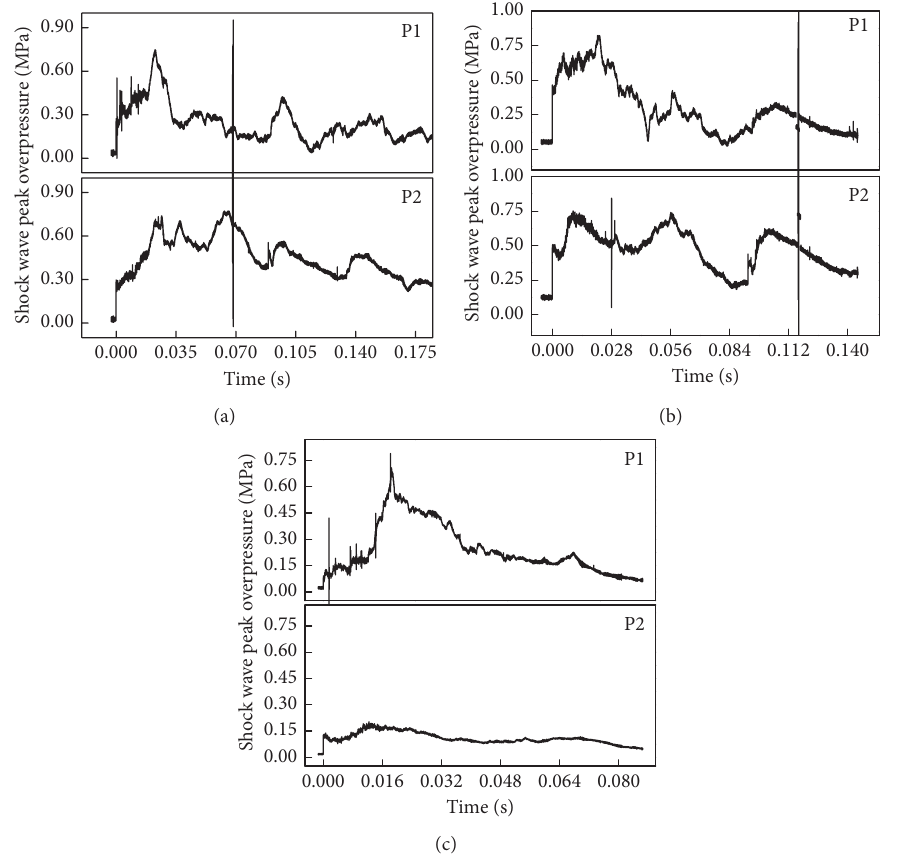
Figure 12: Shock wave time pressure travel curve of cavity with different widths. (a) 500 ∗ 300 ∗ 200. (b) 500 ∗ 500 ∗ 200. (c) 500 ∗ 800 ∗ 200. Table 3: Shock wave peak overpressure information before and behind different width cavities. Flame sensor number P 1 P 2 500 ∗ 300 ∗ 200 Peak overpressure information （ MPa ）